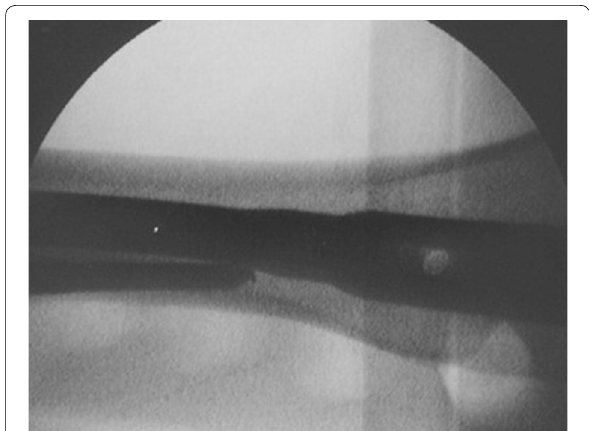
Fig. 1 Intraoperative image intensifier spot of femur showing the relationship between the fiches and nail in lateral